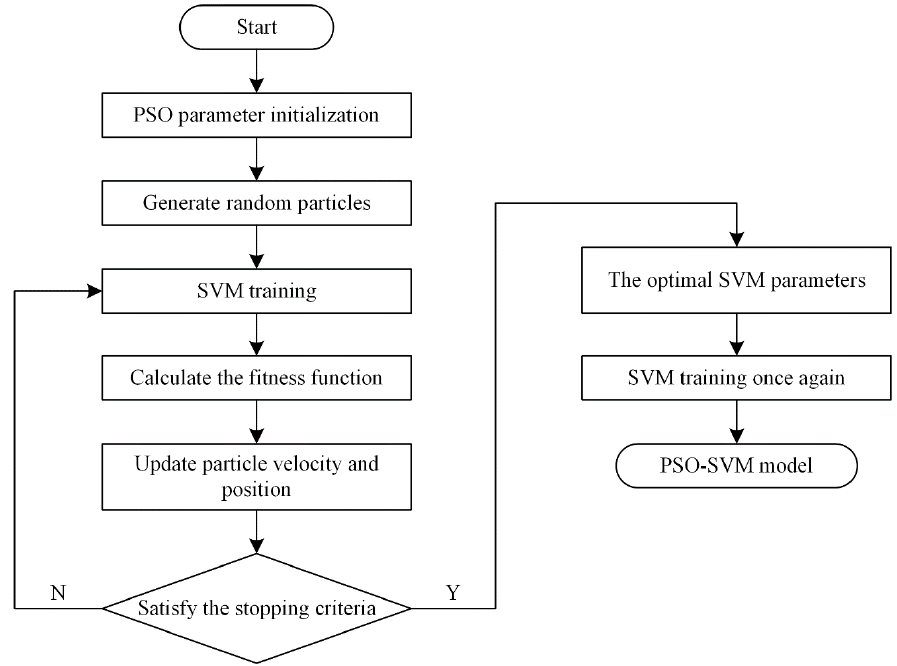
Figure 2. The flow diagram of particle swarm optimization-support vector machine (PSO-SVM) model construction.